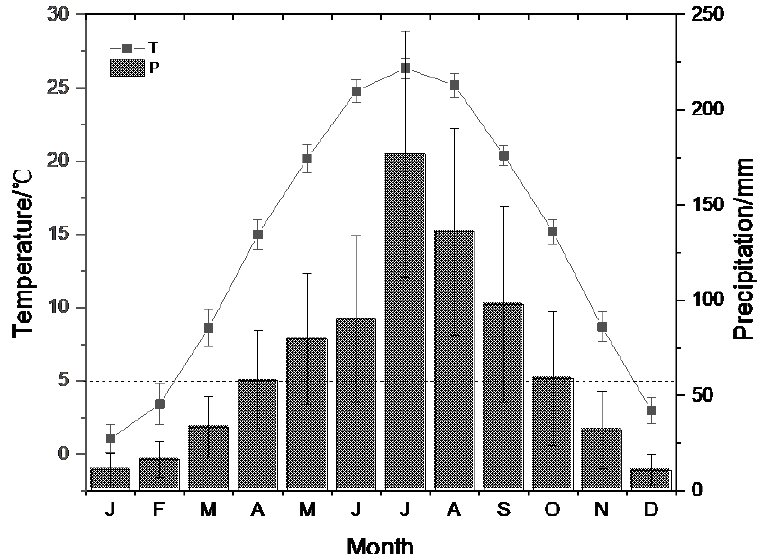
Figure 3. Monthly mean temperature (T) (SD: 0.9–1.91) and monthly total precipitation (P) (SD: 10.46–80.06) averaged from four meteorological stations near Mt. Yao during